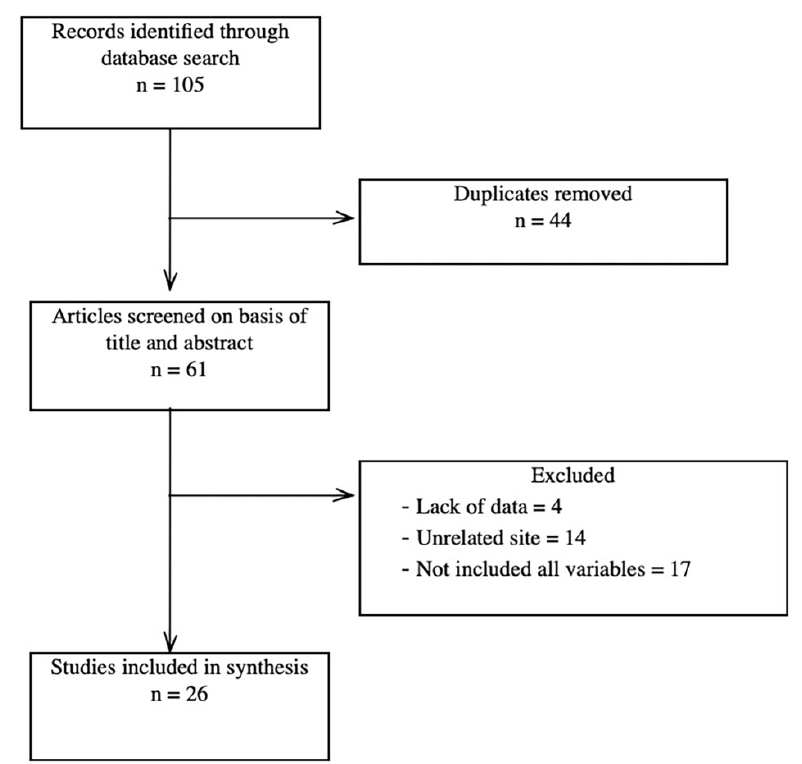
Figure 1. PRISMA flow diagram.